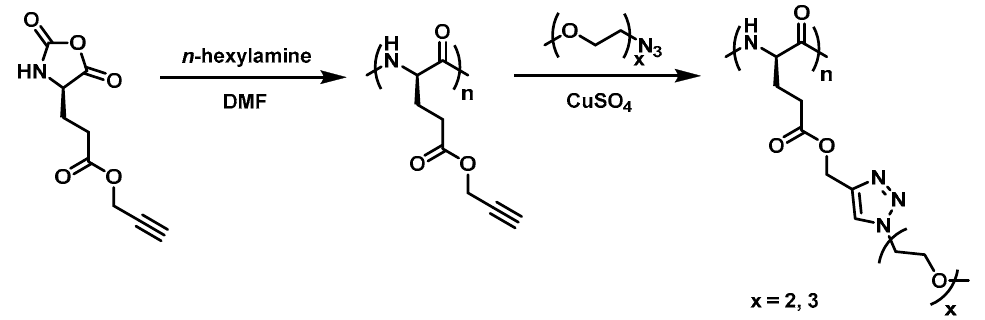
Figure 14. Synthesis route of the OEG graft poly( L -glutamate) by Chen’s group. Reproduced with permission [37]. Copyright 2011, Royal Society of Chemistry.